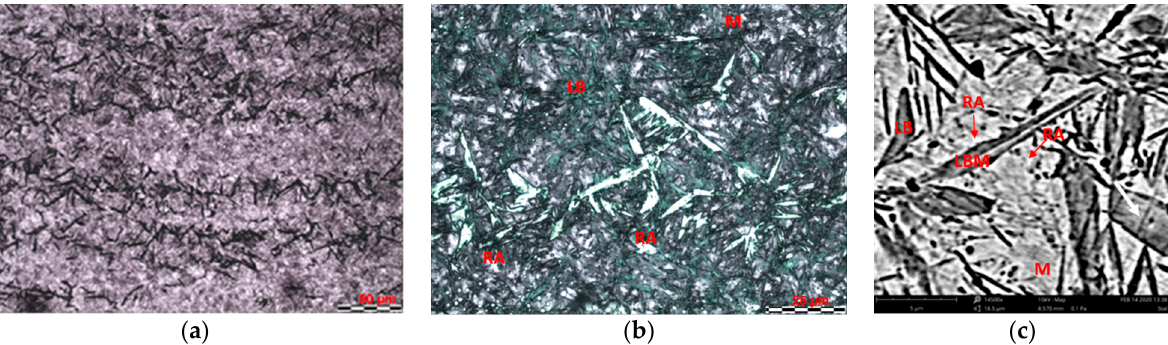
Figure 12. Microstructure of steel 100CrMnSi6-4 after austempering at 150 °C: ( a ) segregation of the microstructure; ( b ) observation of the microstructure details showing lower bainite plates (LB), retained austenite (RA), and martenzite (M) etched with Nital; and ( c ) a SEM micrograph of the lower bainite with midrib (LBM) formed at 150 °C.